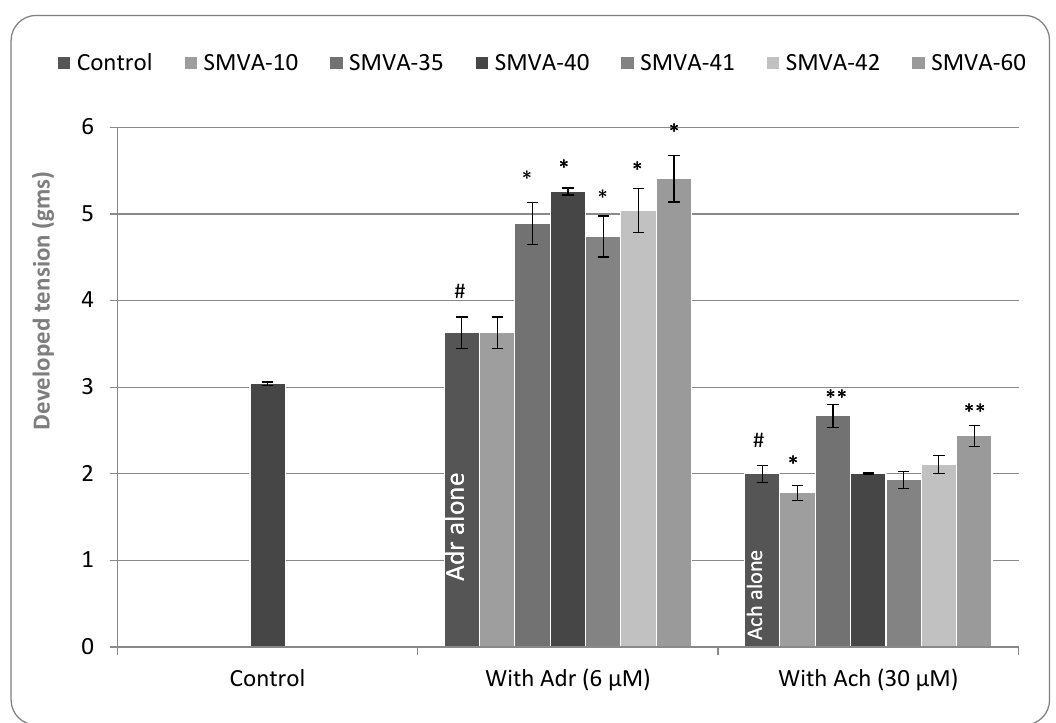
Figure 1. Effects of new synthetic derivatives of thiazole acetic acid on developed tension (gm) in isolated rat hearts in the presence of either adrenaline (Adr) or acetylcholine (Ach). Values are represented as mean ± SEM. Statistics: One-way ANOVA. # p < 0.001 compared with control and * p < 0.05, ** p < 0.01 compared with Adr/Ach.